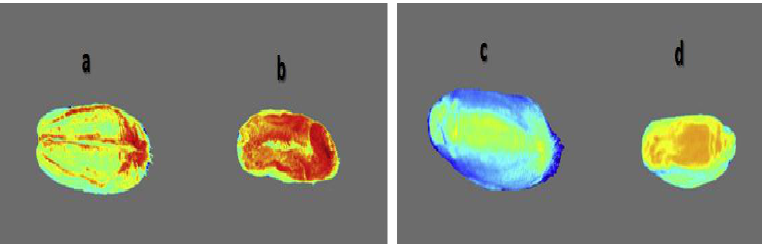
Figure 9. PCA score-images issued from PCA on whole images for the ( a ) resistant and ( b ) susceptible wheat genotypes; and the predicted contamination images resulting from SMLR model in the ( c ) resistant and ( d ) susceptible wheat genotypes kernels in which a kernel highly contaminated have a lot of red pixels (adapted from Jaillais et al. [74]).